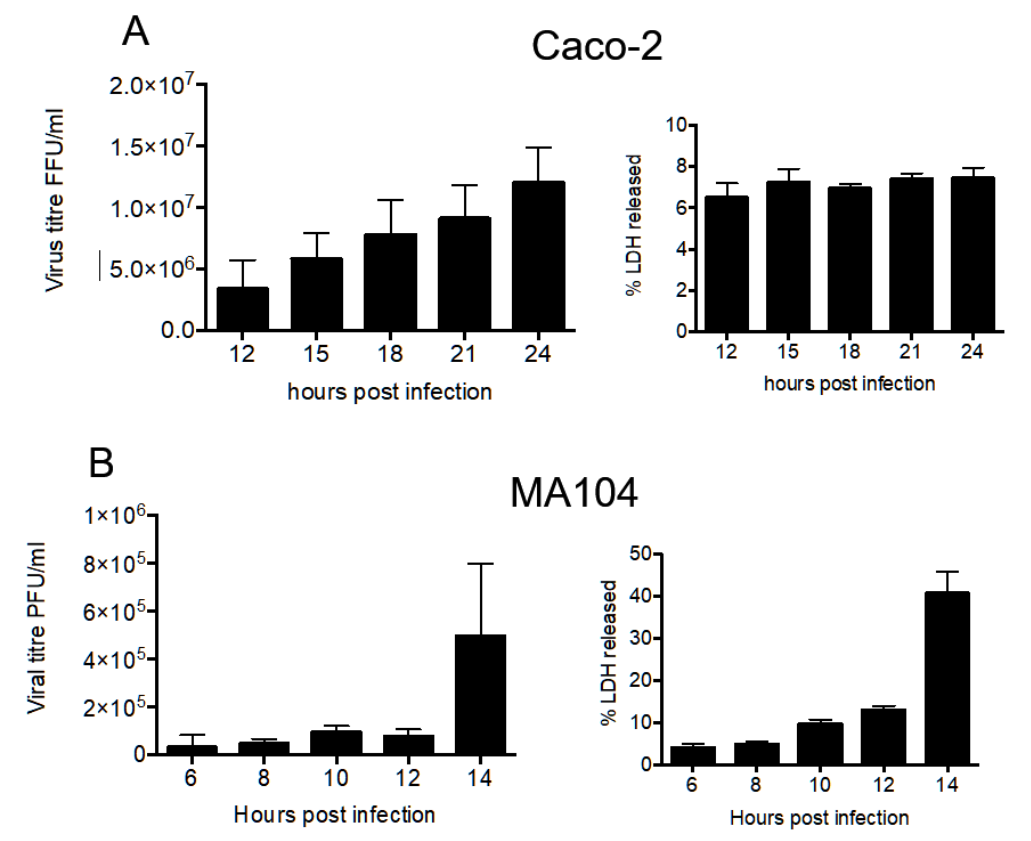
Figure 1. Kinetics of rotavirus release from Caco-2 and MA104 cells. Caco-2 ( A ) and MA104 ( B ) cells were infected by RRV rotavirus strain (MOI 5). At the indicated time points, the supernatant was collected and the virus present was determined as described in material and methods. In right part of the figure is the release of LDH, as a measure of cell membrane integrity. The arithmetic means and standard deviation of three independent experiments are shown.